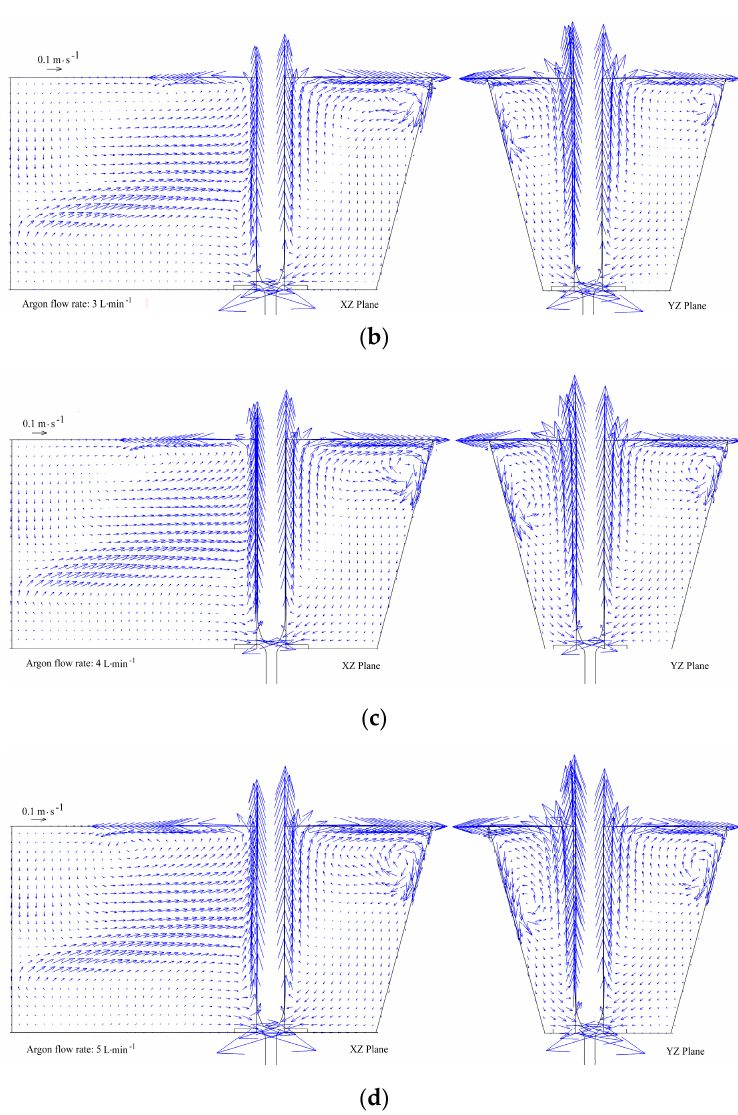
Figure 7. Flow behavior of liquid steel in the tundish under different argon flow rates: ( a ) 2 L · min − 1 , ( b ) 3 L · min − 1 , ( c ) 4 L · min − 1 , and ( d ) 5 L · min − 1 .